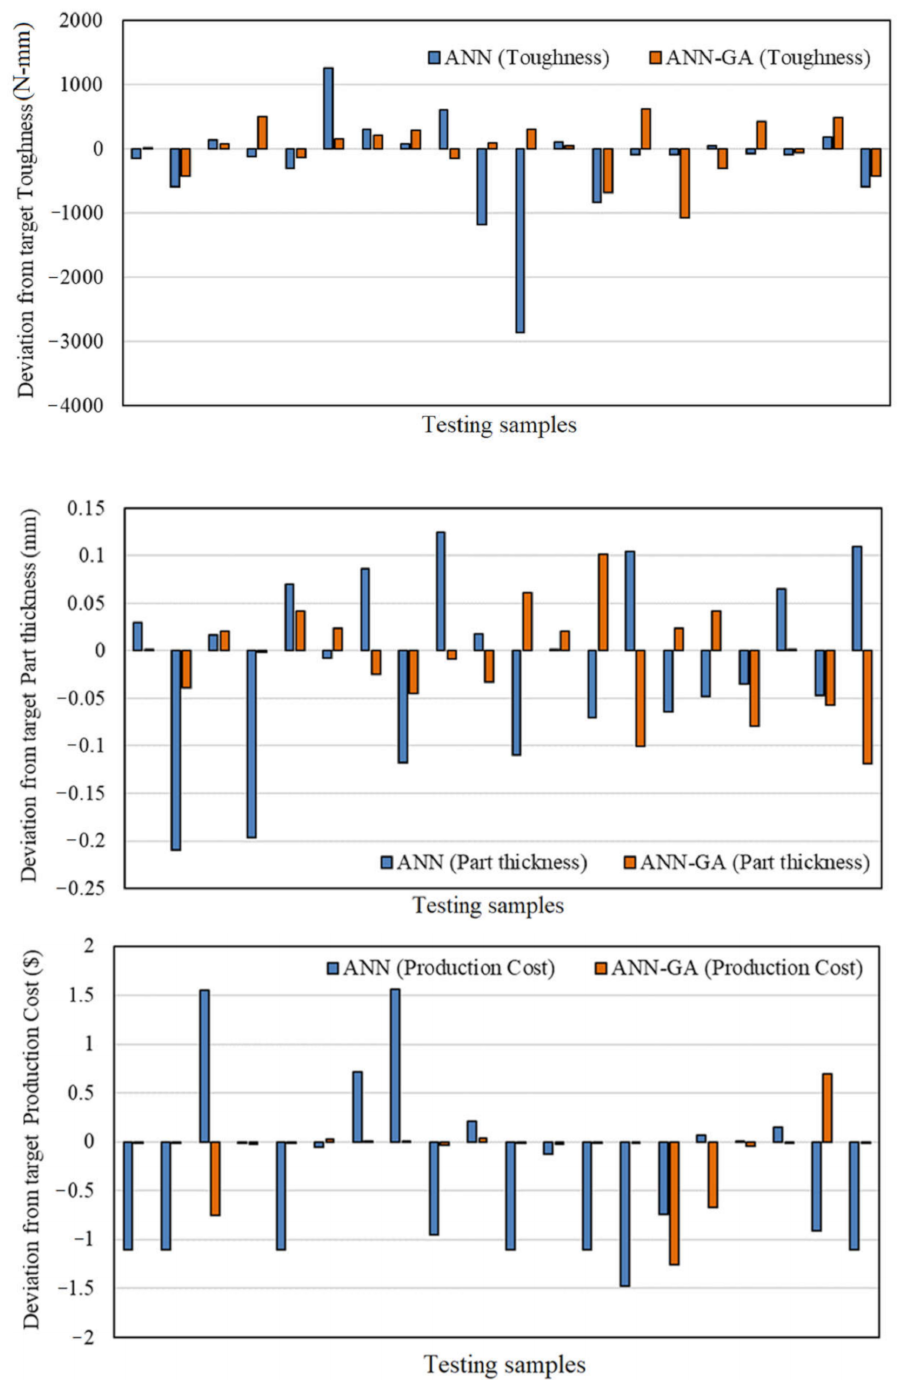
Figure 13. Deviation from the target values for the hybrid ANN-GA and single ANN